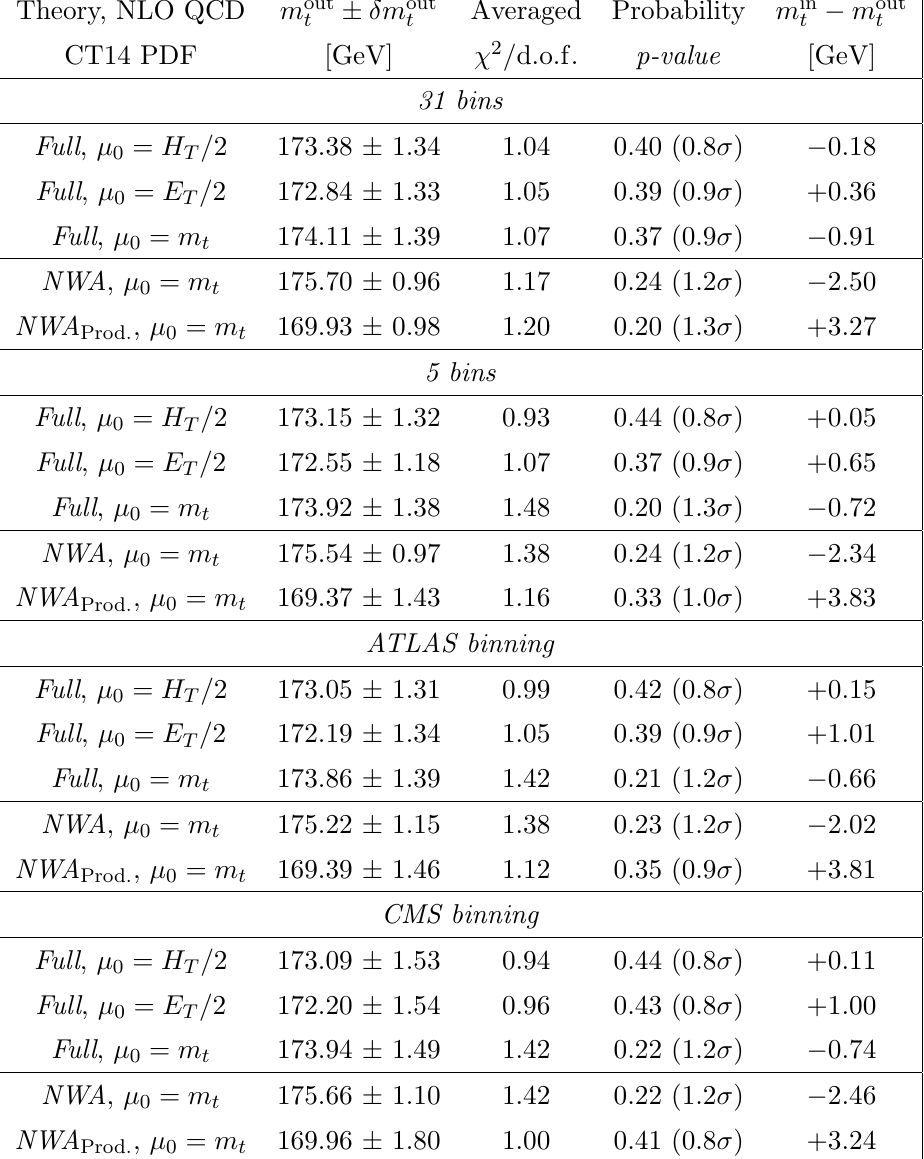
Table 4 . Mean value of the top quark mass, m out , from 1000 pseudo-experiments as obtained from t the normalised (cid:26) s di(cid:11)erential distribution for the pp e + (cid:23) e (cid:22) (cid:0) (cid:22) (cid:23) (cid:22) b (cid:22) bj + X production process at ! the LHC with p s = 13 TeV. Also shown is 68 % C.L. (1 (cid:27) ) statistical error of the top quark mass, (cid:14)m out , together with the averaged minimal (cid:31) 2 =d:o:f and the p-value. The number of standard t deviations corresponding to each p-value is presented in parentheses. In the last column the top quark mass shift, de(cid:12)ned as m in m out , with m in = 173.2 GeV, is also given. Luminosity of 2.5 fb (cid:0) 1 t (cid:0) t t is assumed.